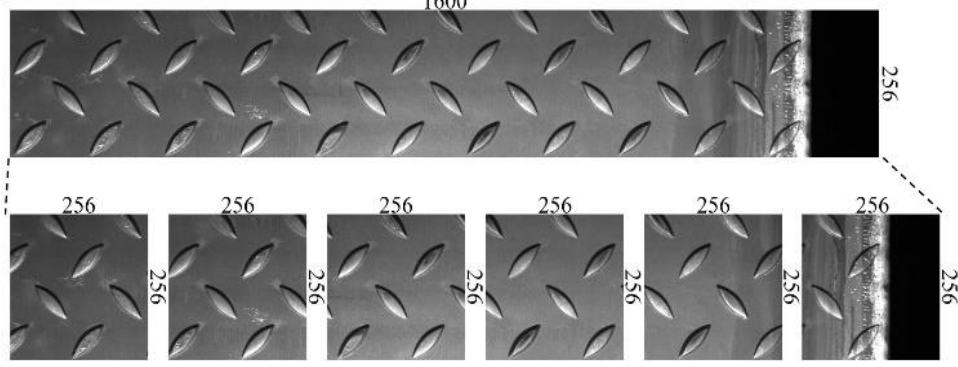
Figure 5. Example of cropped steel defect images ( 256 × 1600 to 256 × 256 )